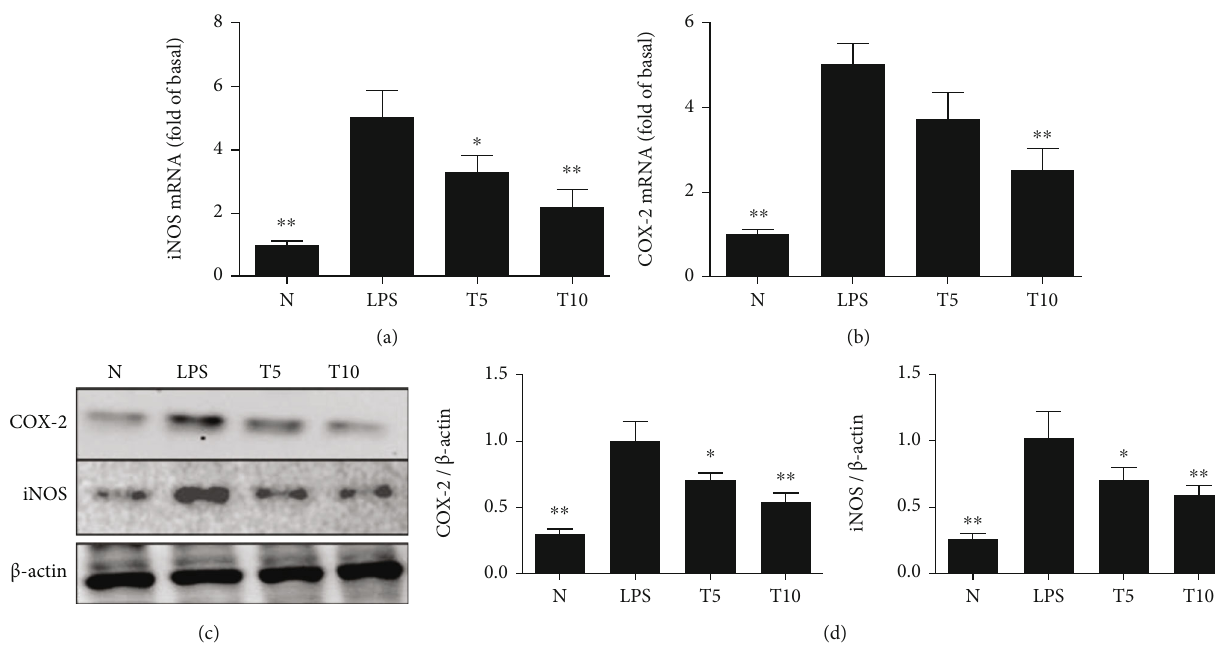
Figure 5: Tomatidine inhibited in fl ammatory mediators in mice. Tomatidine decreased the (a) gene expression of iNOS and (b) COX-2 in the lungs and suppressed (c) iNOS and COX-2 protein expressions. (d) The fold change in the expressions of COX-2 and iNOS protein was measured relative to the expression of β -actin, respectively. Data are presented as the mean ± SEM . ∗ p < 0 : 05 and ∗∗ p < 0 : 01 vs. LPS group. N group: normal control mice; LPS group: LPS treatment only; T5 group: 5 mg/kg tomatidine plus LPS; T10 group: 10mg/kg tomatidine plus